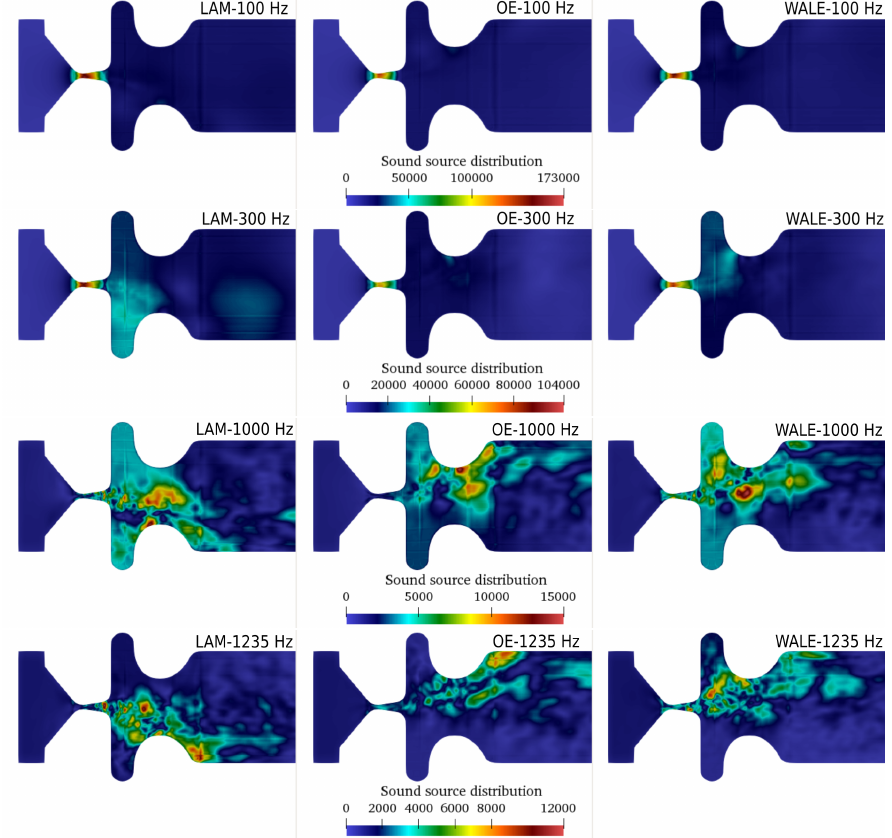
Figure 8. Spatial distribution of sound sources [kgm − 6 s − 2 ] in mid–coronal plane at four frequencies (as a result of Fast Fourier